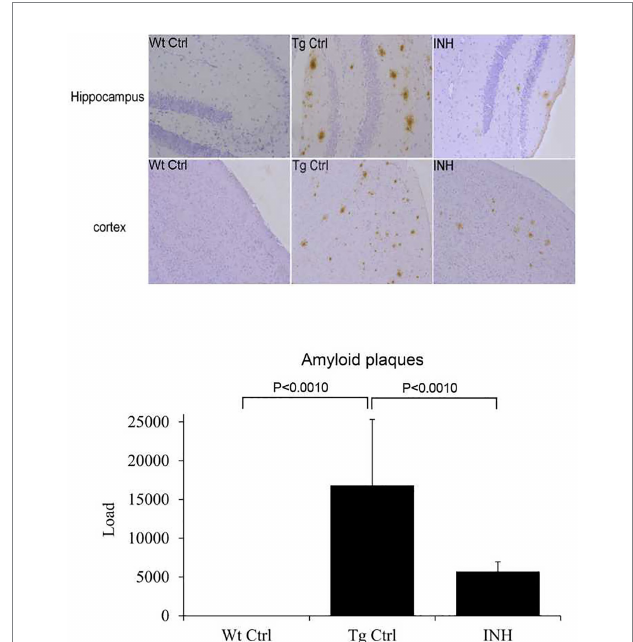
FIGURE 2 INH decreases A β plaques in the brains of APP/PS1 mice. The representative images of IHC staining for A β 1-42 in the hippocampus and cortex were shown. The bar chart showed the quantitative result of A β plaques in the IHC